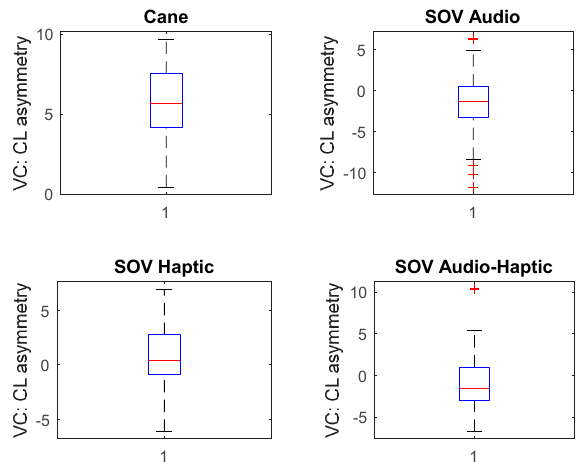
Figure 28. Visual cortex activity for UserA (early-blind).